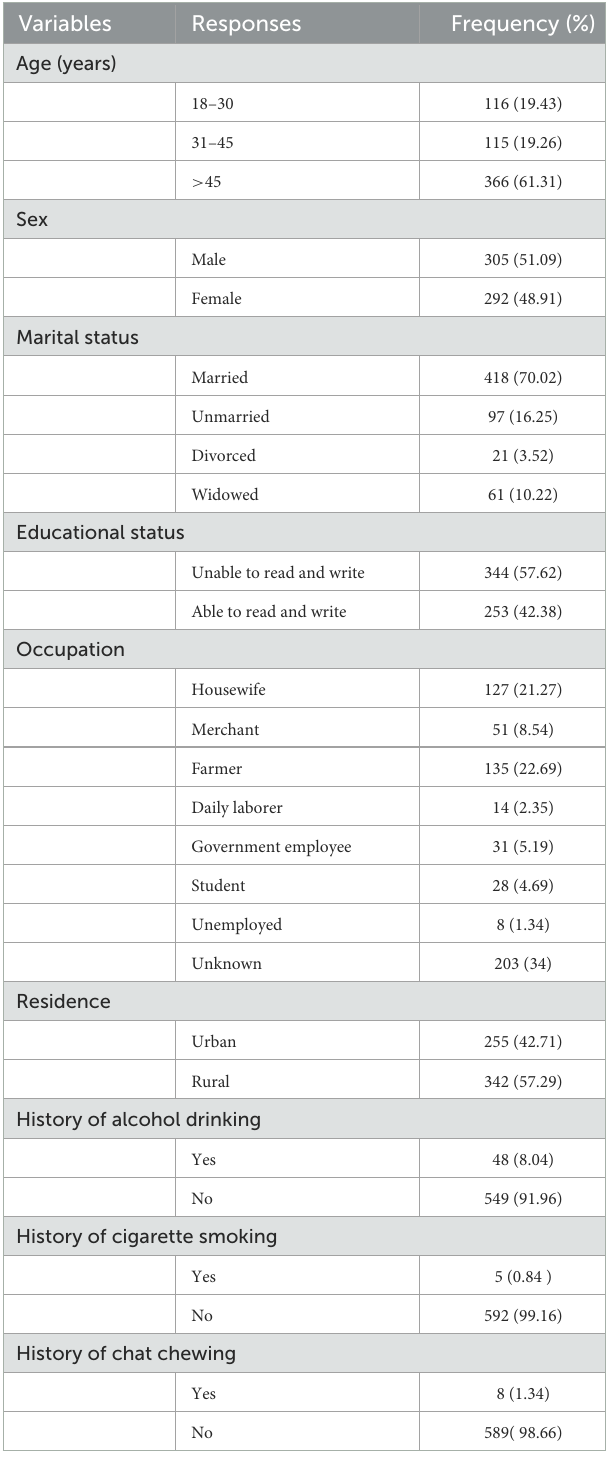
TABLE 1 Socio-demographic and baseline behavioral characteristics among adult chronic illness patients admitted at the University of Gondar Comprehensive Specialized Hospital, Northwest Ethiopia, 2016–2020 (N =